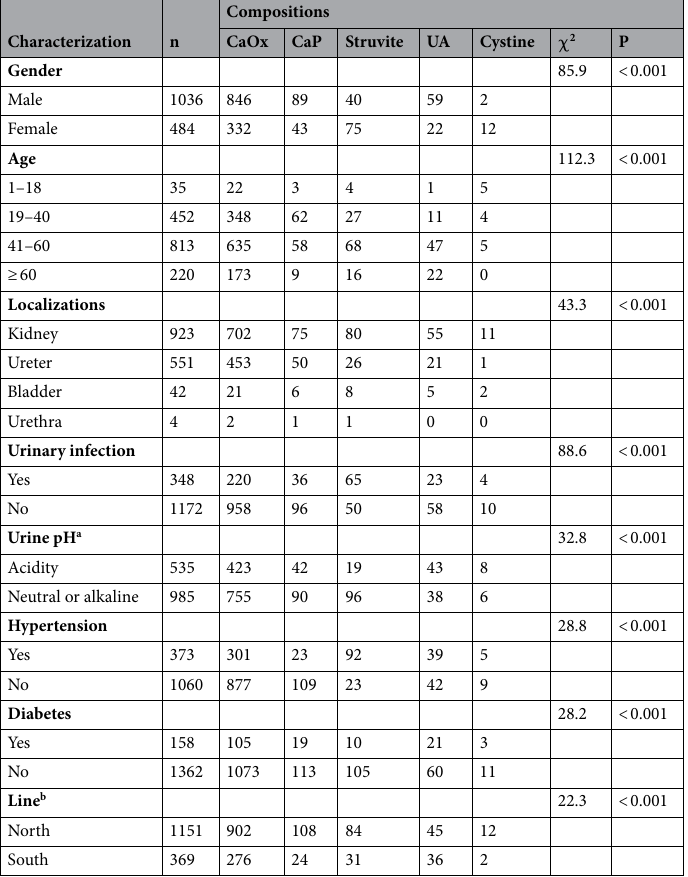
Table 4. Characteristics of patients stratified by stone composition. CaOx calcium oxalate, CaP calcium phosphate, UA urate stone. a Urine is considered acidic when its PH ≤ 5.5, otherwise it will be considered neutral or alkaline. b The Qinling Mountain-Huaihe River